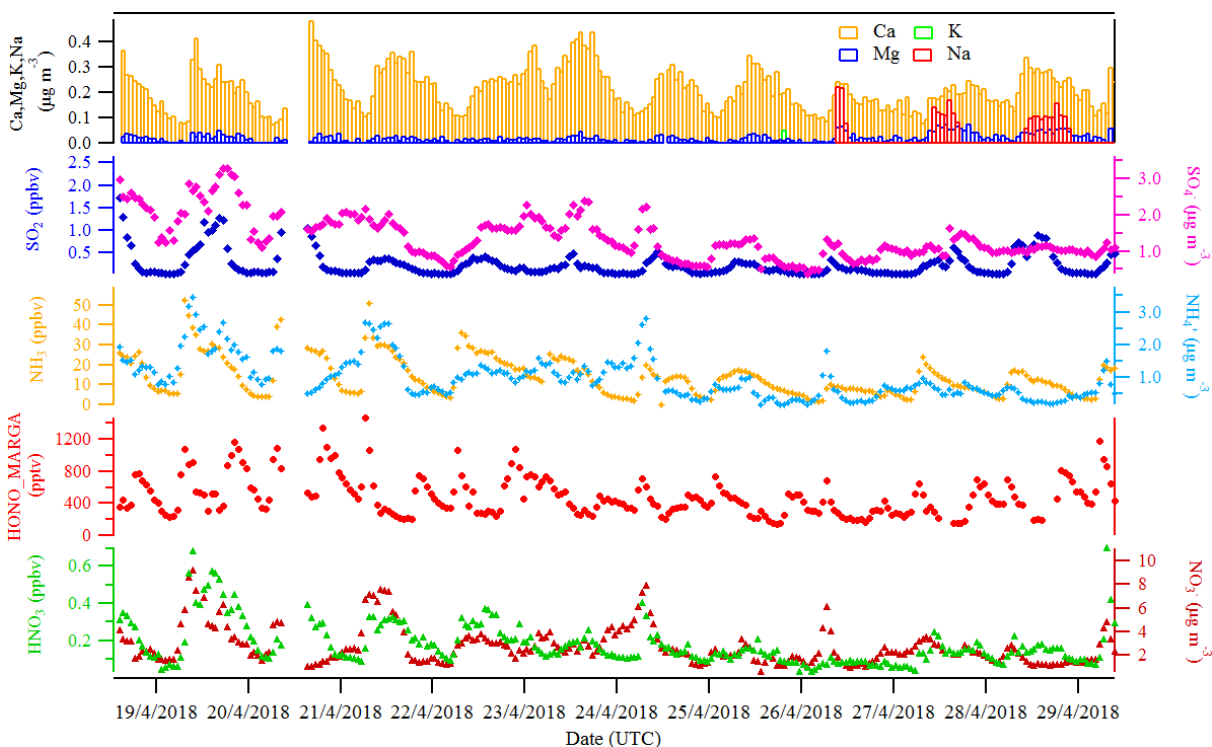
Figure 3. The hourly time-resolved quantification of water-soluble ions in PM 10 (NO − corresponding trace gases (HONO, HNO 3 , SO 2 , NH 3 ) were measured by MARGA in Melpitz from 19 to 29 April 2018.